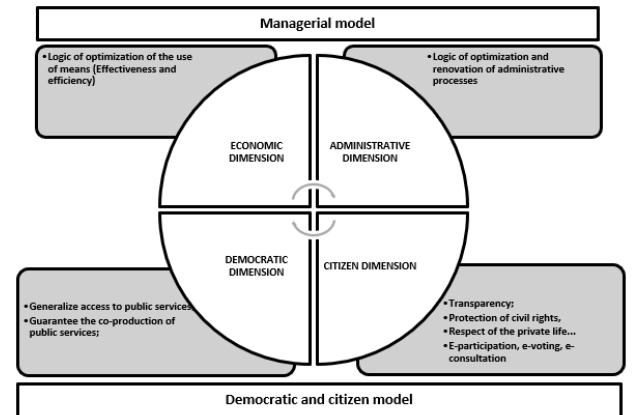
Figure 3. A new framework for assessing the effects of ICT on public value creation (source: authors’ conception adapted from Mergel, 2020; Bonina & Cordella,